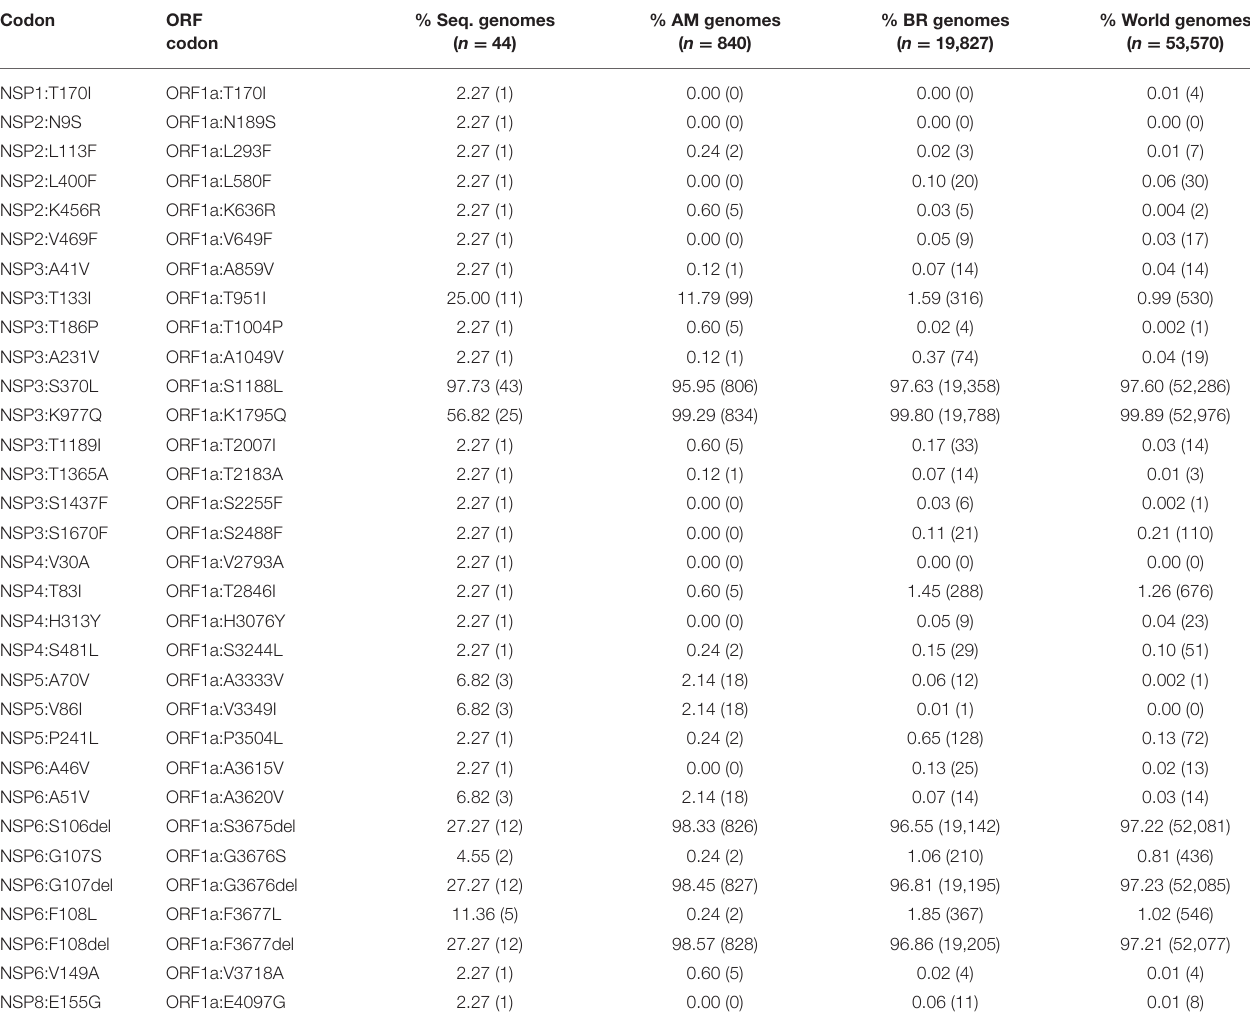
TABLE 2 | Frequency of ORF1a mutations identified in the P.1 sequenced genomes (this study) compared with sequences from Amazonas, Brazil and World (up to September 12, 2021) available on GISAID. Codon ORF codon